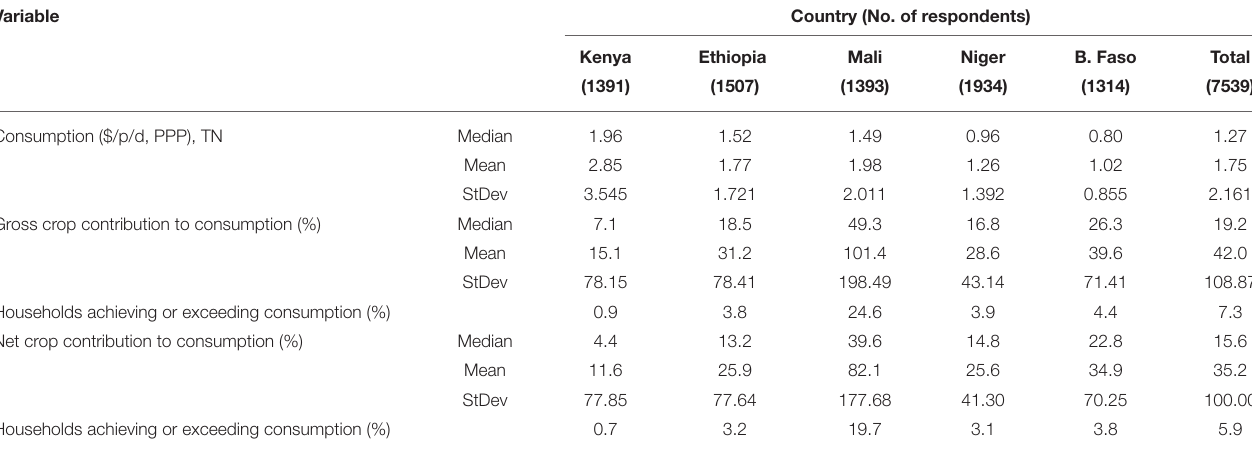
TABLE 2 | Household consumption ($ per person per day), the percentage contribution of gross- and net crop contribution to it and the percentage of households for which crop production meets or exceeds it. Variable Country (No. of